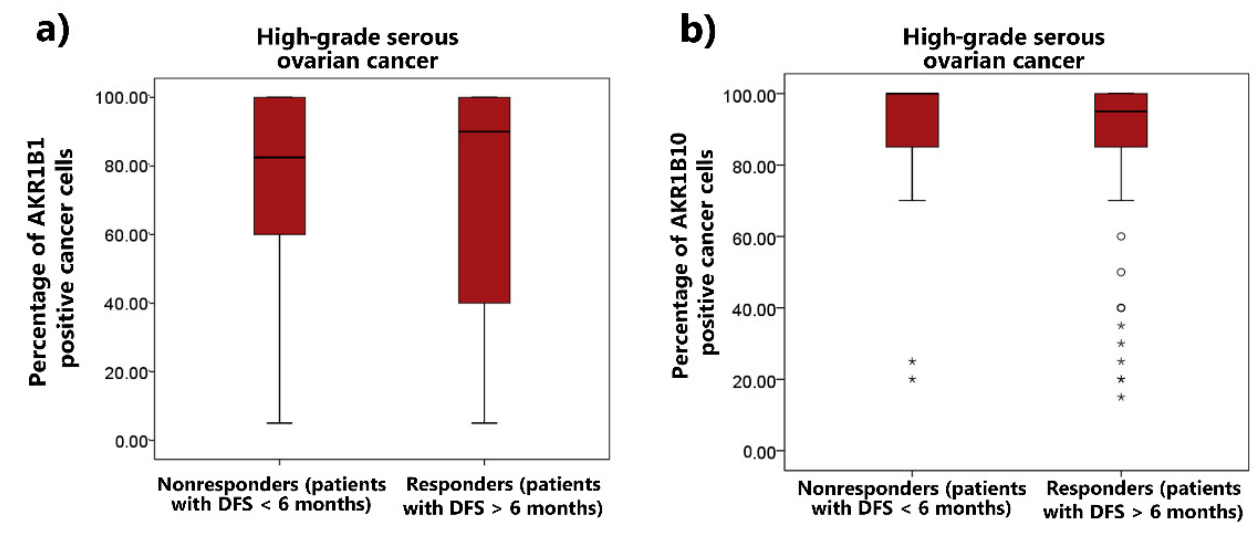
Figure 8. ( a ) AKR1B1 and ( b ) AKR1B10 distributions between patients with HGSC and different responses to chemotherapy. Median values, boxes from the 25th to 75th percentiles, and whiskers that correspond with the 25th percentile minus 1.5 times the interquartile range and with the 75th percentile plus 1.5 times the interquartile range are shown. ° represents mild outliers; * represents